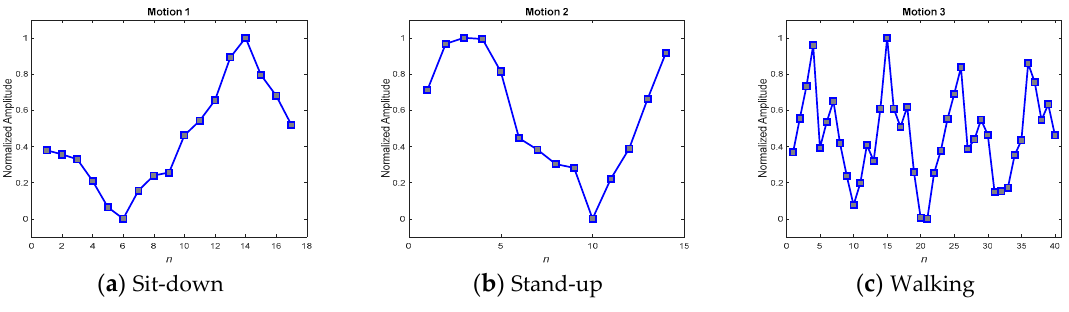
Figure 16. Randomly selected MPPs for motions 1–3, without any averaging procedure.